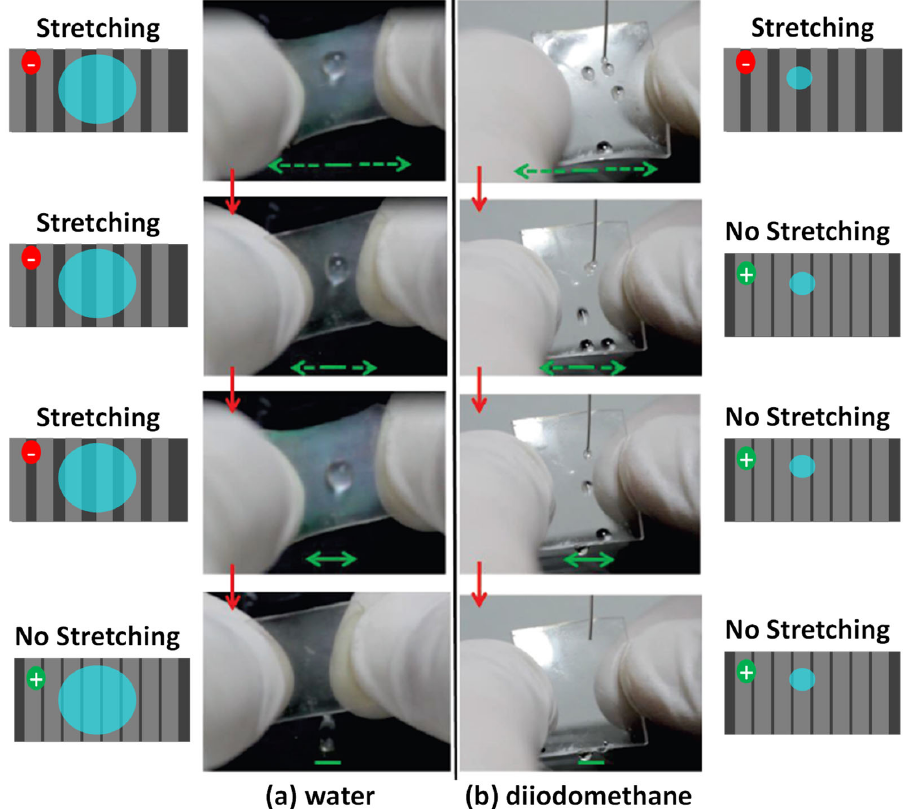
Figure 4. Rolling-off control of liquid droplets on TiO 2 /PDMS samples. ( a ) Photographs of 30 µ L Figure 4. Rolling ‐ off control of liquid droplets on TiO 2 /PDMS samples. ( a ) Photographs of 30 μ l water droplet on a 85 ◦ -TiO 2 /PDMS sample in a highly stretched state (top), which is progressively water droplet on a 85° ‐ TiO 2 /PDMS sample in a highly stretched state (top), which is progressively released (bottom); ( b ) idem for 5 µ L diiodomethane droplets on 60 ◦ -TiO 2 /PDMS sample. Green released (bottom); ( b ) idem for 5 μ l diiodomethane droplets on 60° ‐ TiO 2 /PDMS sample. Green arrows indicate the direction and magnitude of stretching. Red arrows indicate the sequence of images. The schemes at the left and right sides represent the self-patterned surface for the samples in the stretched (top) and non-stretched (bottom) states, highlighting the different distribution of PDMS (dark regions in the grooves) and TiO 2 (light regions) zones in the examined samples. Positive sliding is represented by green circles and pinned situations by red